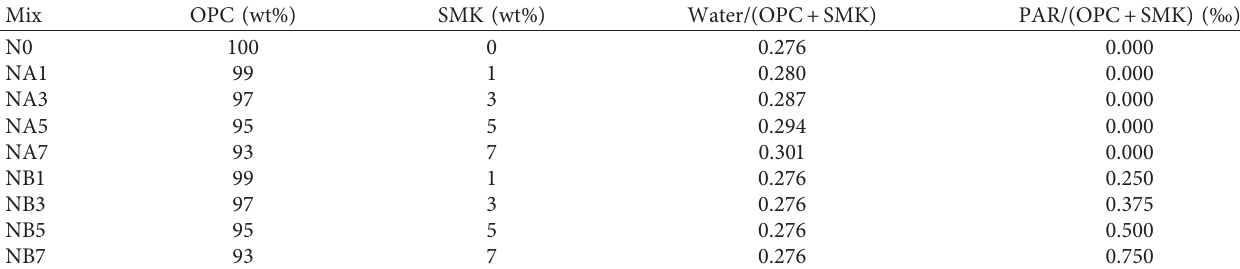
Table 1: Mix proportions of the HCS